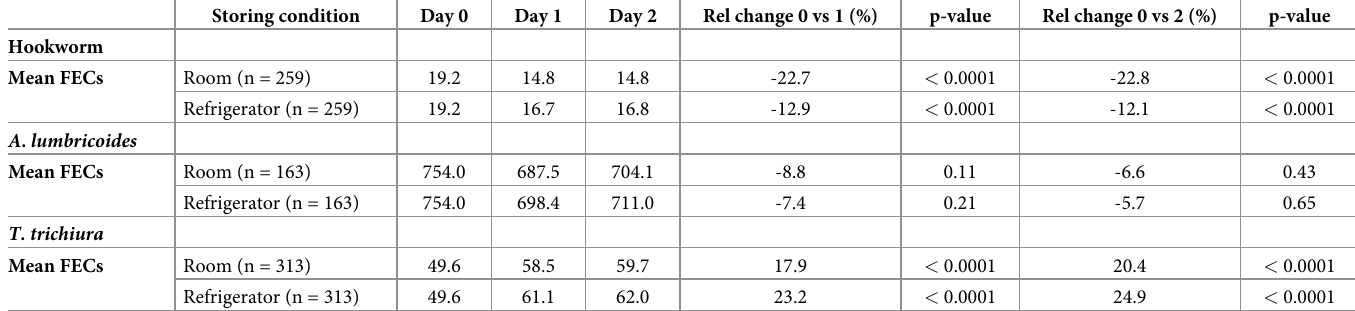
Table 3. Whole sample storing experiment: Mean FECs of day 0, day 1 and day 2 for hookworm, A . lumbricoides and T . trichiura . Rel change = relative change, FECs = fecal egg counts, A . lumbricoides = Ascaris lumbricoides , T . trichiura = Trichuris trichiura . Storing